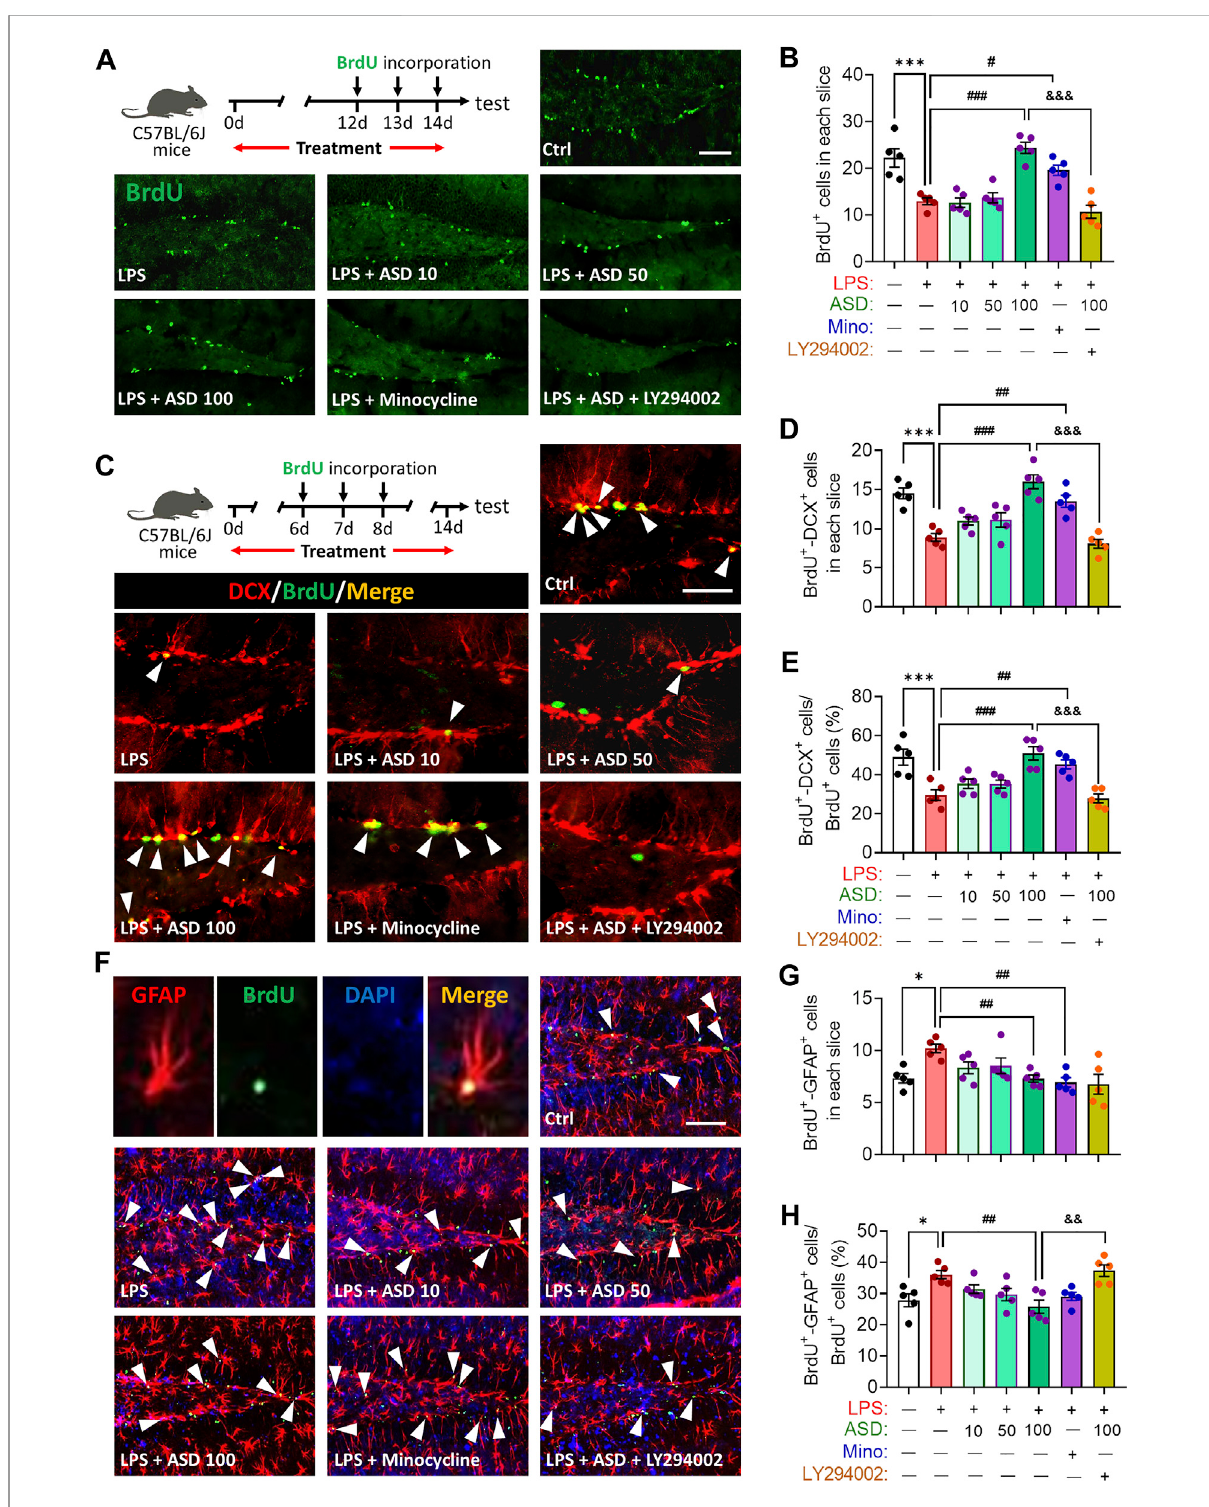
FIGURE 4 Effects of ASD on NSPC proliferation and differentiation in dentate gyrus of mice chronically exposed to LPS. (A) , Timeline for detecting proliferation of neural stem/progenitor cells (NSPCs) based on immuno fl uorescence micrographs of BrdU + cells in dentate gyrus (DG) of mice. Proliferating NSPCswerelabeledusing5 ′ -bromo-2 ′ deoxyuridine(BrdU)(green).Scalebar, 100 μ m. (B) , Quanti fi cationofhippocampalBrdU +cells. Five mice from each group were examined, and fi ve hippocampal micrographs (40×) from each animal were quanti fi ed. (C) , Timeline